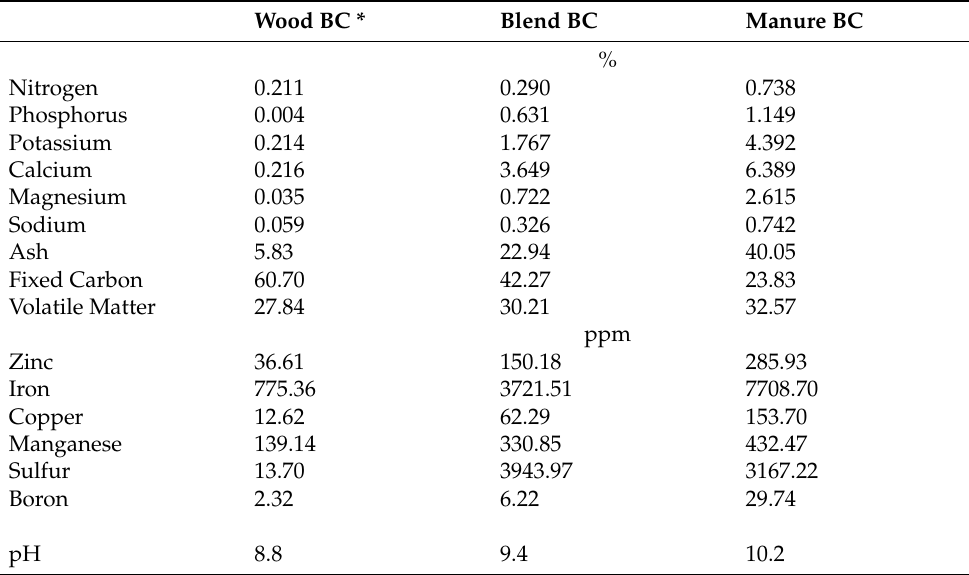
Table 6. Initial biochar